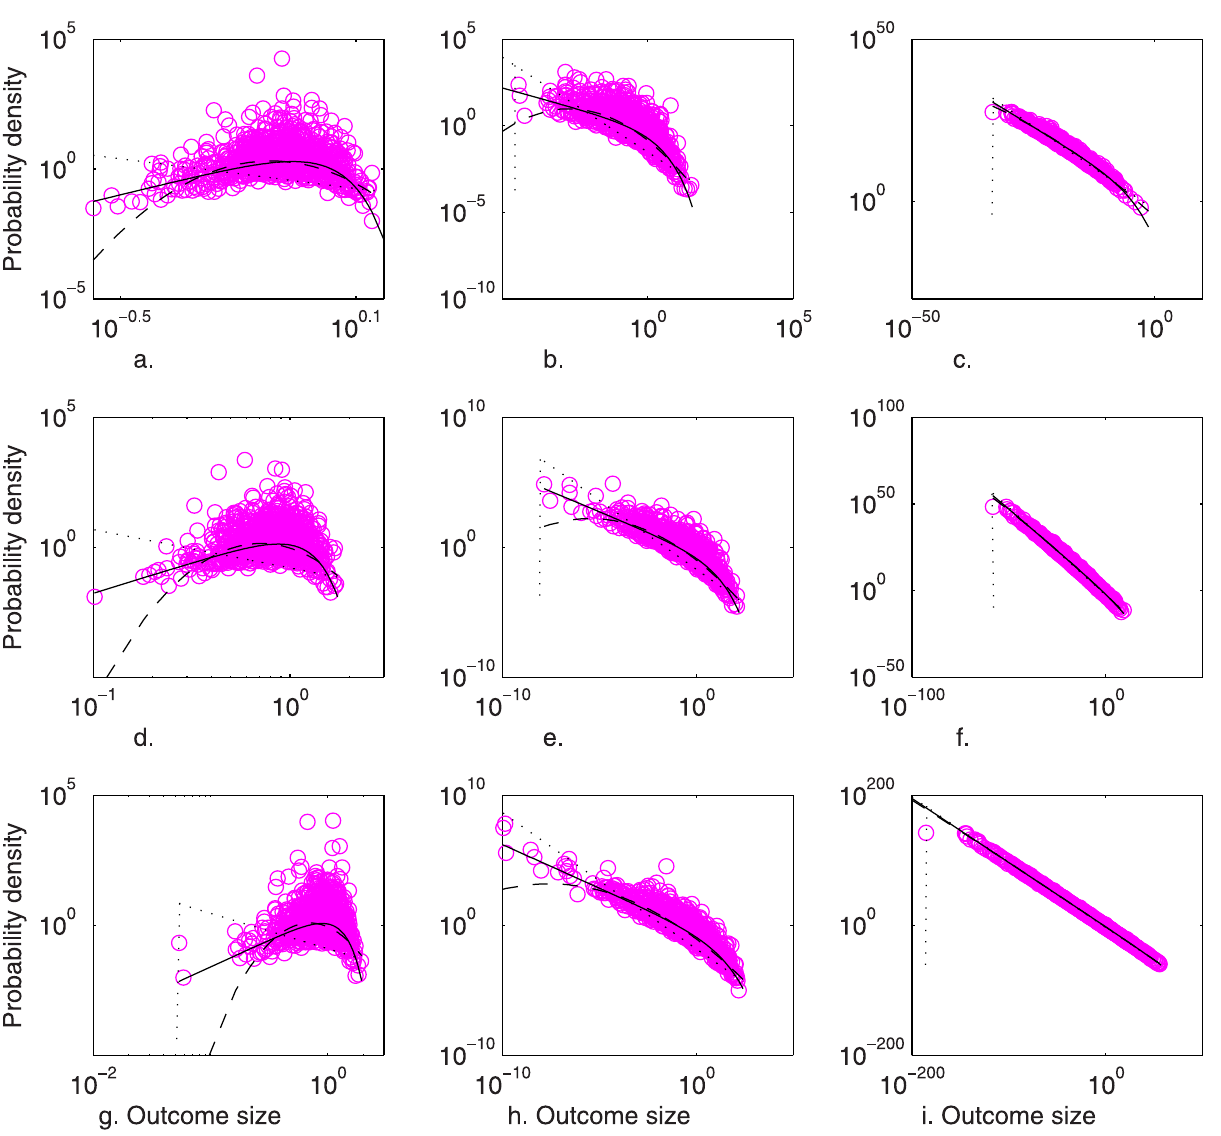
Fig 1. Simulated (o) and fitted Weibull ( –– ), lognormal ( — ), and Pareto I ( ... ) distributions of the products of perfectly independent standard exponential RVs, c i' '. Panels were simulated as (a) exp